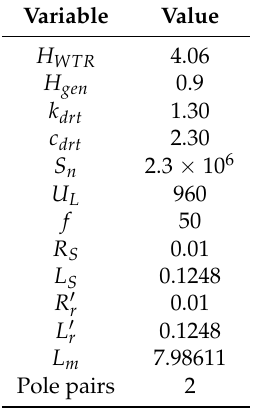
Table A2. Parameters of Type 2 WT